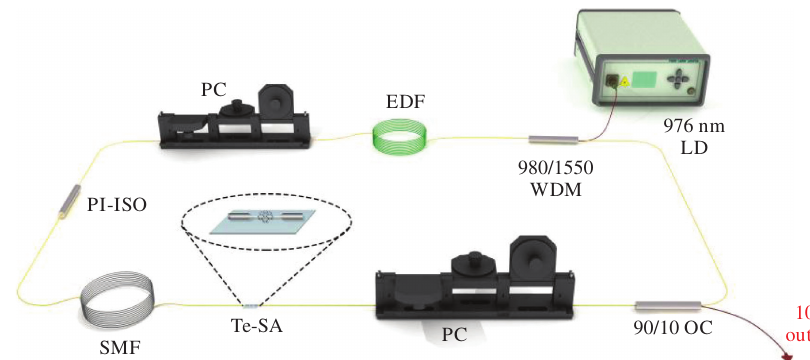
Figure 7: Experimental setup of tellurene-based SA mode-locked EDF